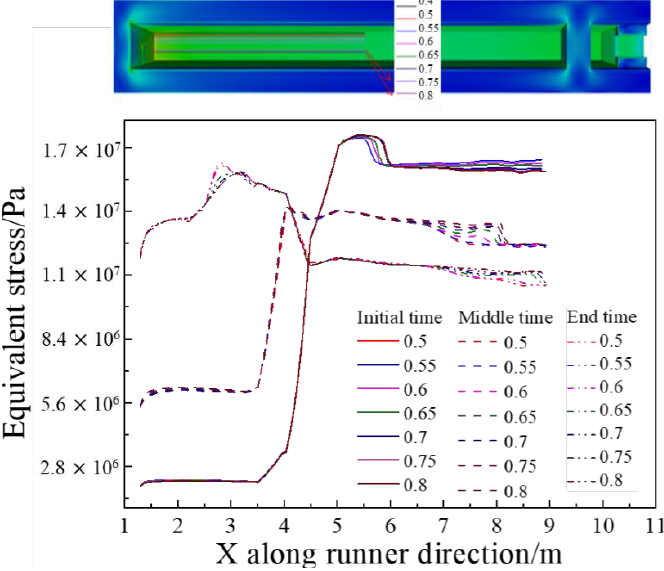
Figure 12. Equivalent stress fluctuations of the bottom of the main trough at different times. Based on the analysis of the shear force and thermal stress, it is concluded that the refractory material on the bottom of the main trough experiences greater thermal stress during the tapping process, and the maximum thermal stress occurs at 4 m on the bottom of the main trough. Therefore, key points for further analysis are selected at this position and in nearby areas in order to observe the stress changes in a working cycle. After calcu- lating the tapping process (which lasted 90 s in the simulations), an equally long period (“tapping gap”) without hot metal supply was simulated to study the working state of the main trough during the tap cycle. This gave the stress curve depicted in Figure 13.